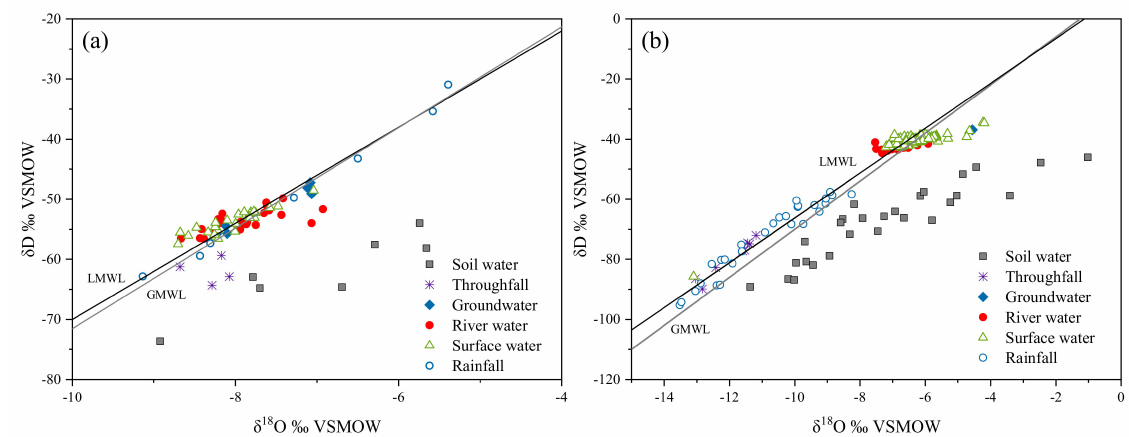
Figure 4. All δ 18 O and δ D data of rainfall, surface water, soil water, groundwater, and stream water relative to the local (LMWL) and global (GMWL) meteoric water lines. The LWML is calculated from rainfall collected in all rainfall events between 2015 and 2016 in the Hemuqiao catchment. ( a ) Typhoon event and ( b ) plum rain